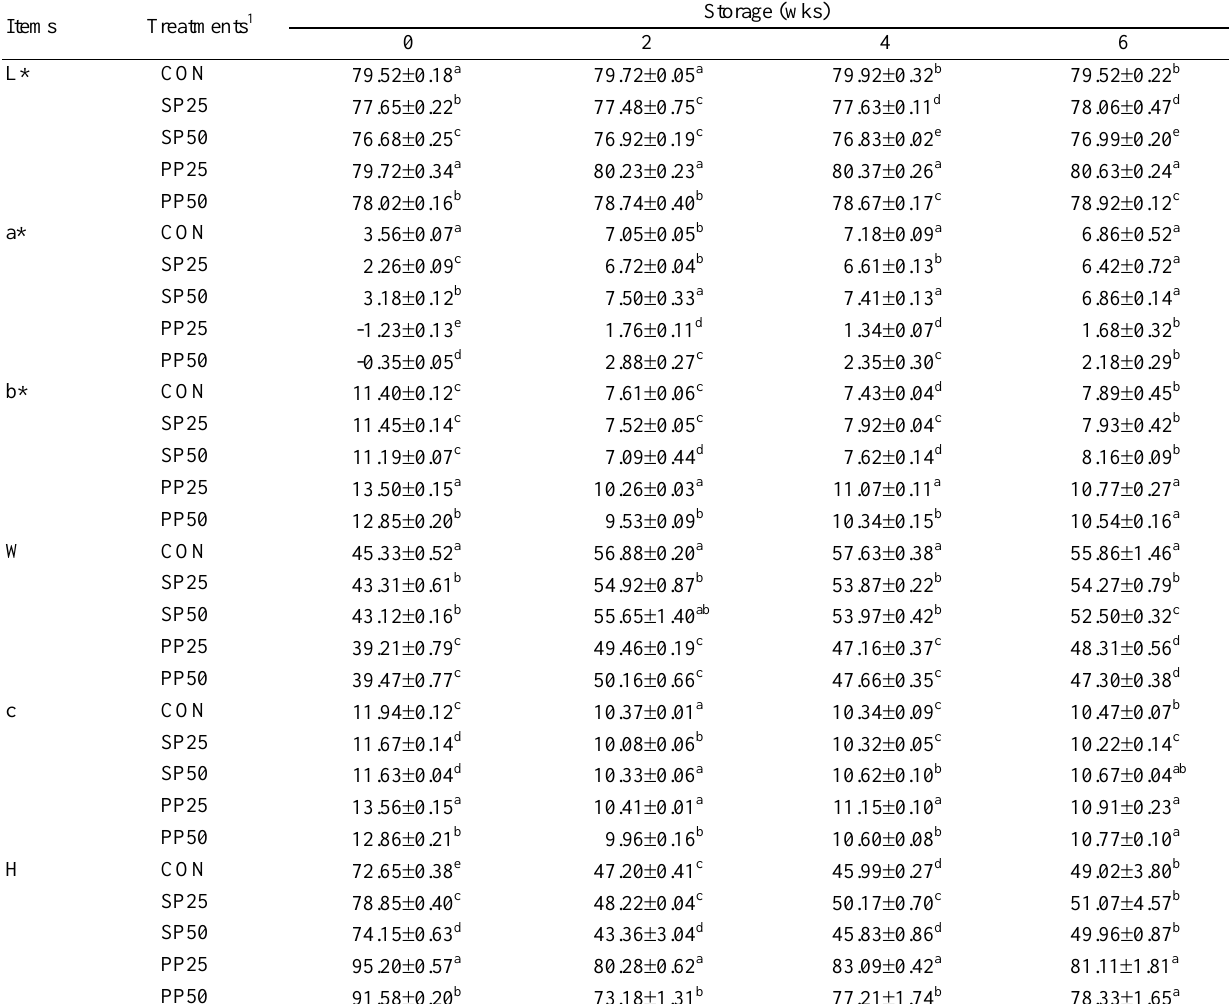
Table 4. CIE L*, a* and b*, whiteness (W), chroma (c), hue (H) and residual nitrite content of cooked pork sausages containing two different percentages of purple sweet potato combined with nitrite during 6 wks of storage at 4  C